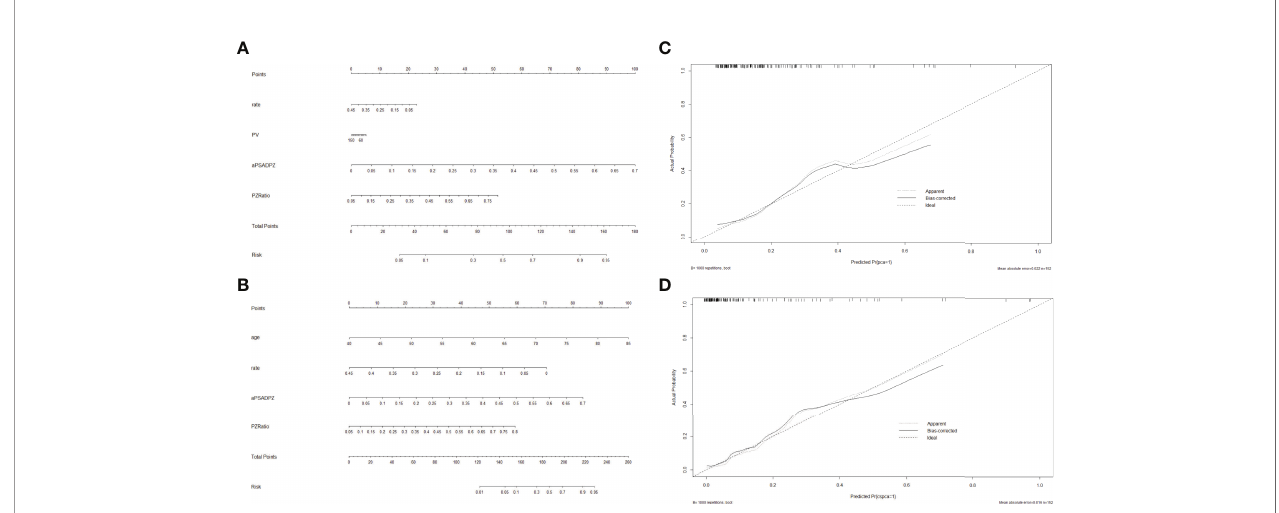
FIGURE 4 | Nomogram of two models for predicting the probability of (A) PCa and (B) csPCa in biopsy-naïve men with PIRADS v2 categories 3. Calibration curves of these two nomograms in the diagnosis of (C) PCa and (D) csPCa in biopsy-naïve men with PIRADS v2 categories 3. PSA, prostate-speci fi c antigen; aPSADPZ, adjusted prostate-speci fi c antigen density of peripheral zone; PV, prostate volume; PIRADS, Prostate Imaging Reporting and Data System; PCa, prostate cancer; csPCa, clinically signi fi cant prostate cancer.